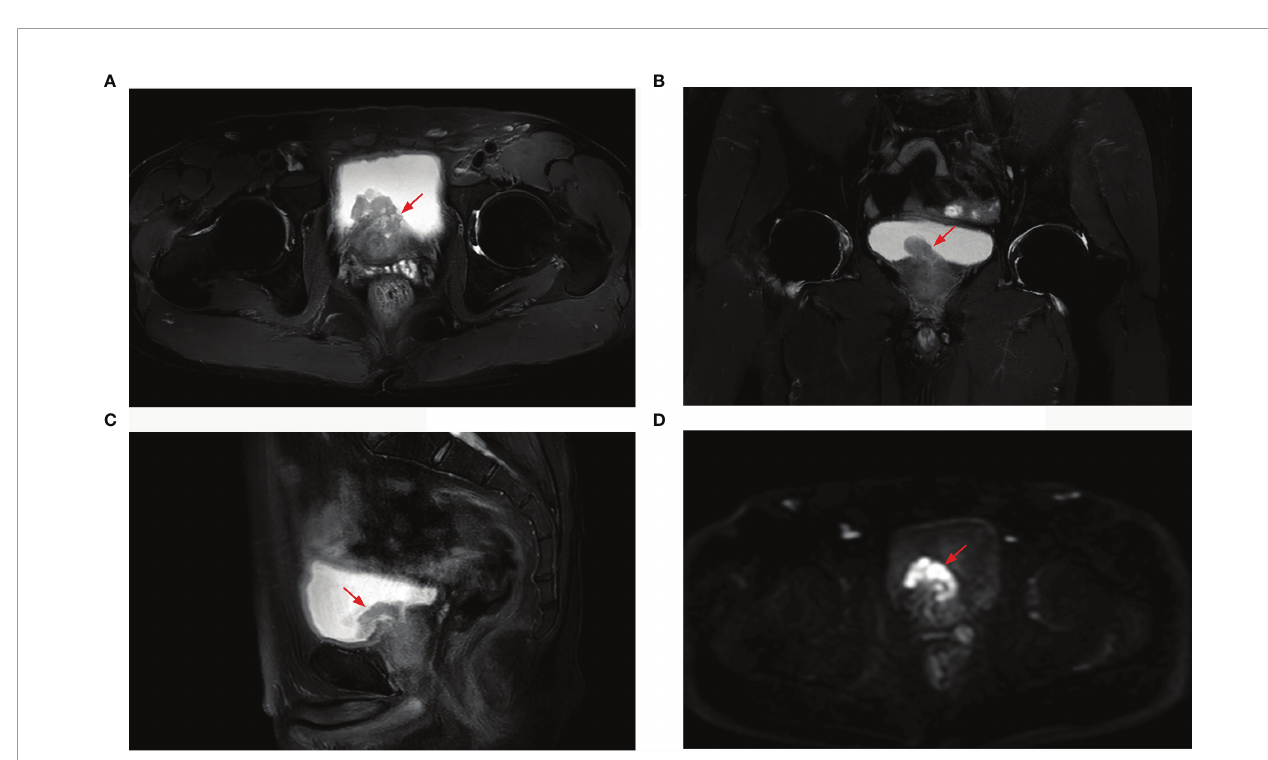
FIGURE 2 | Prostate MRI revealing prostate cancer with bladder invasion, a marked hyperintensity on T2-weighted imaging [ (A) axial, (B) coronal, (C) sagittal], and hypointensity on diffusion-weighted imaging (D)